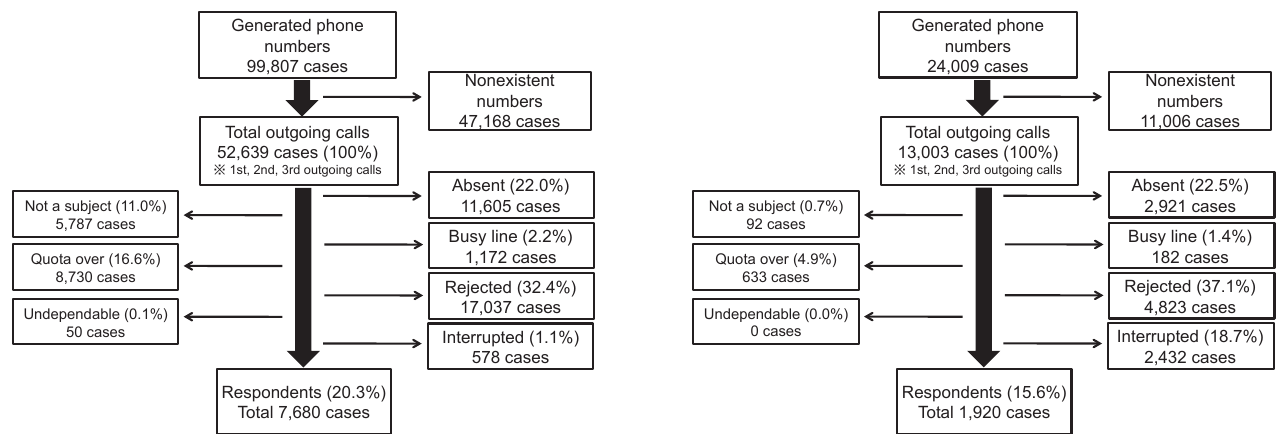
Figure. Respondent collection process through RDD phone survey (Left: landline telephone, Right: